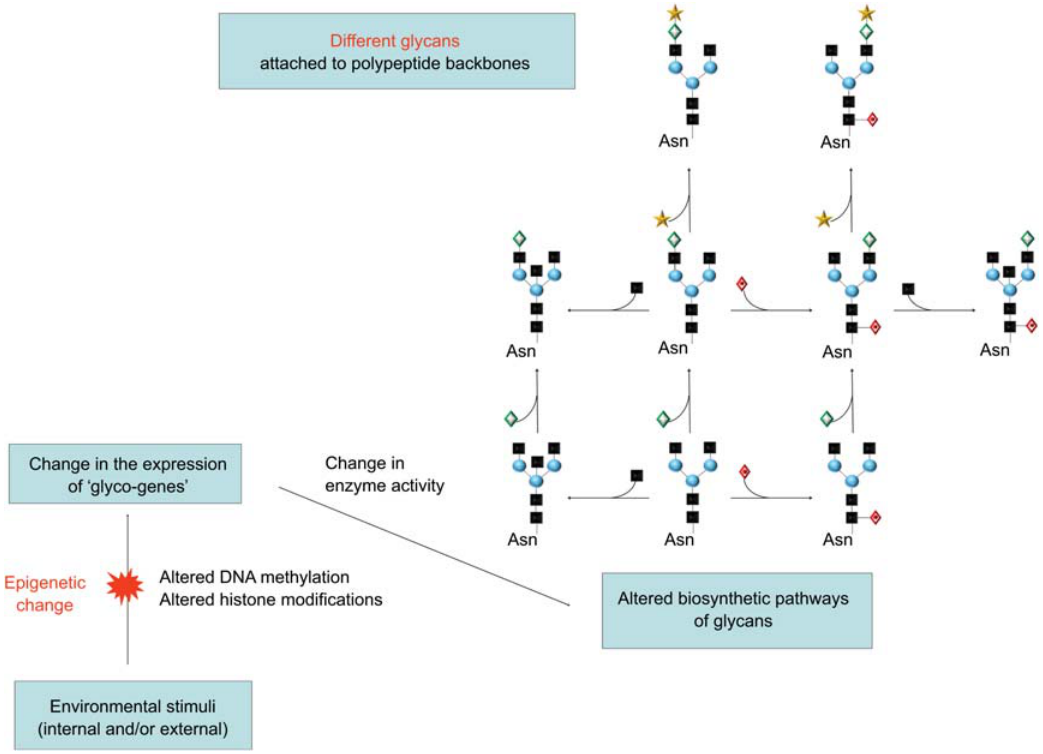
Figure 2 Epigenetic regulation of protein